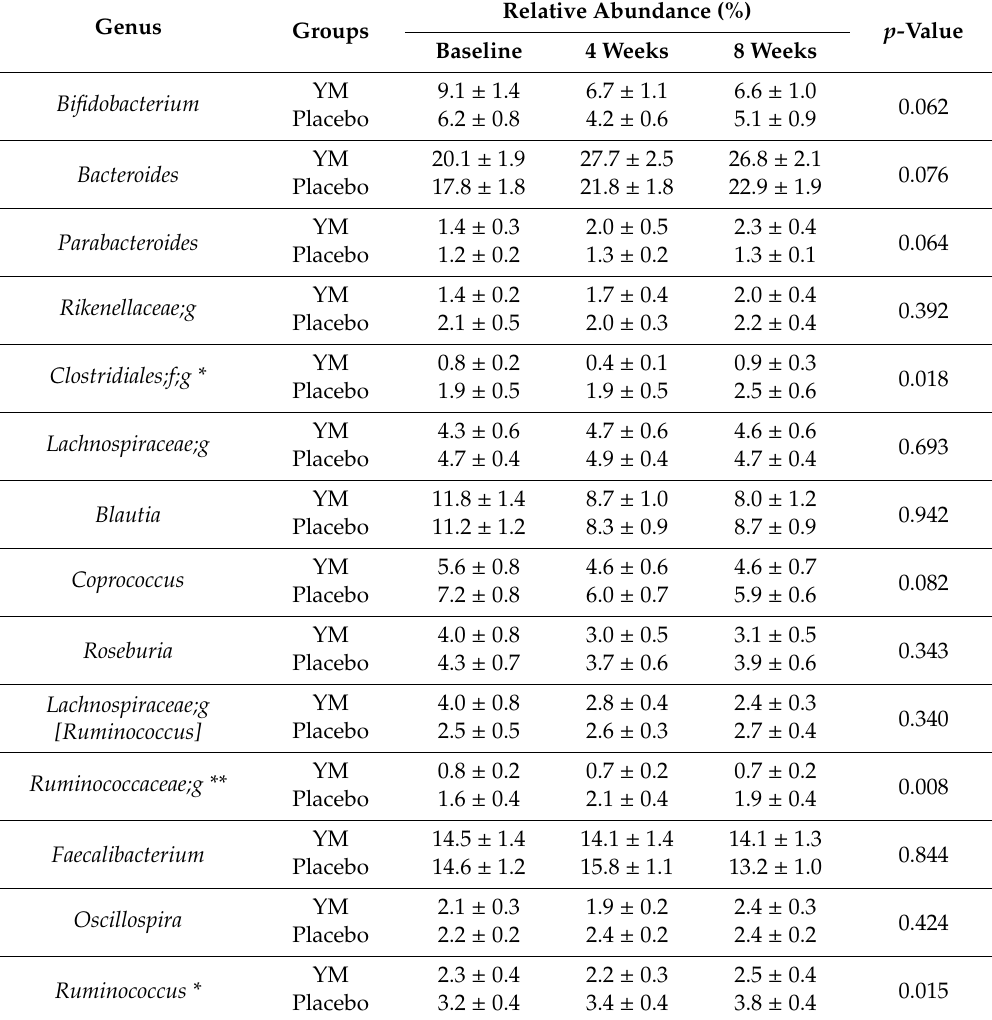
Table 3. Comparison of fecal microbiota between the YM and placebo